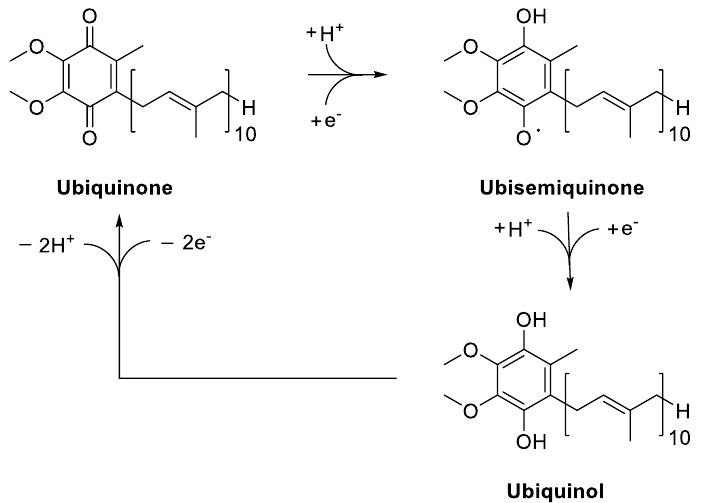
Figure 2. Redox cycling of Coenzime Q 10 .